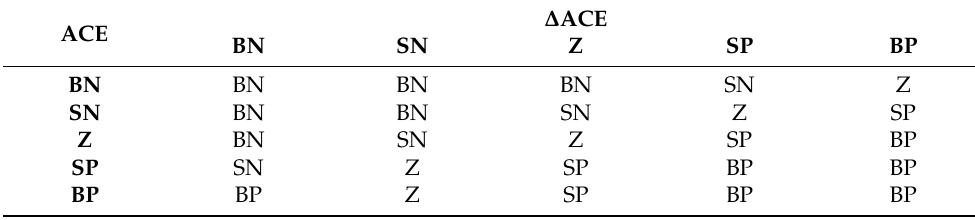
Figure 4. MFs for FLC. Table 1. FLC input and output